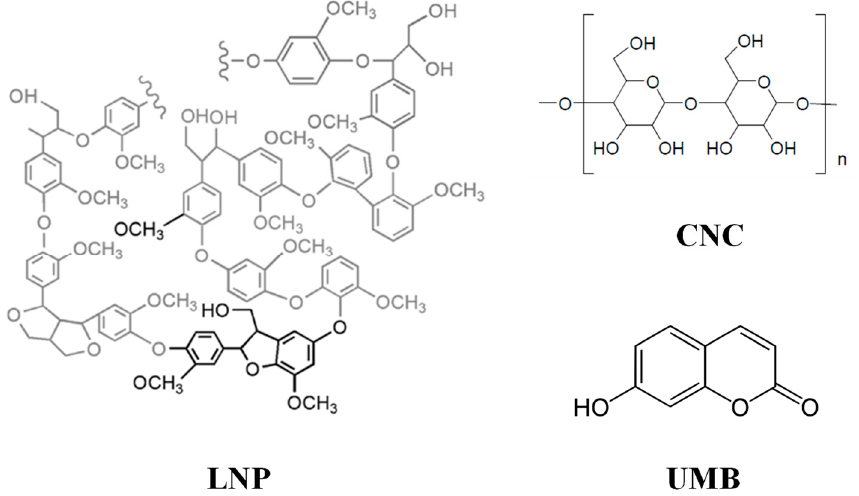
Figure 1. Chemical structures of lignin (LNP), cellulose (CNC) and umbelliferone